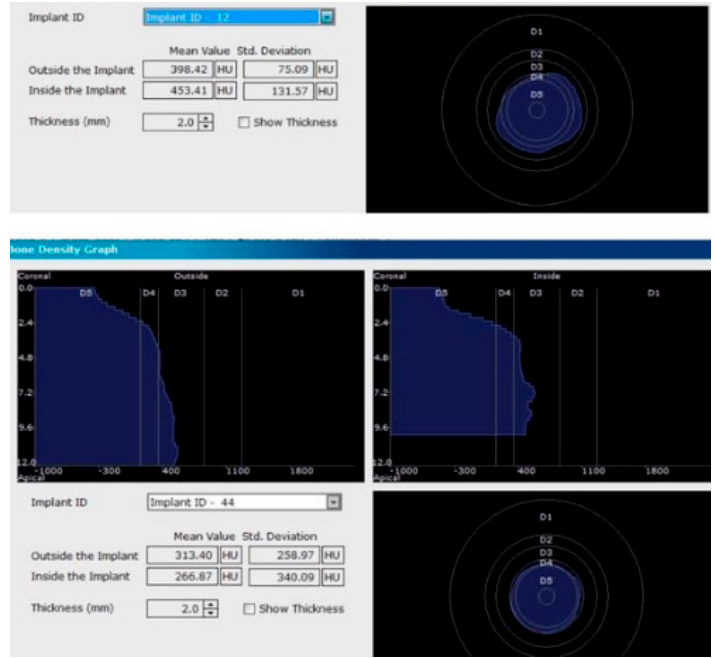
Figure 5. Image showing the bone density measured in Hounsfield units (HU) as well as the standard deviations of the volume.